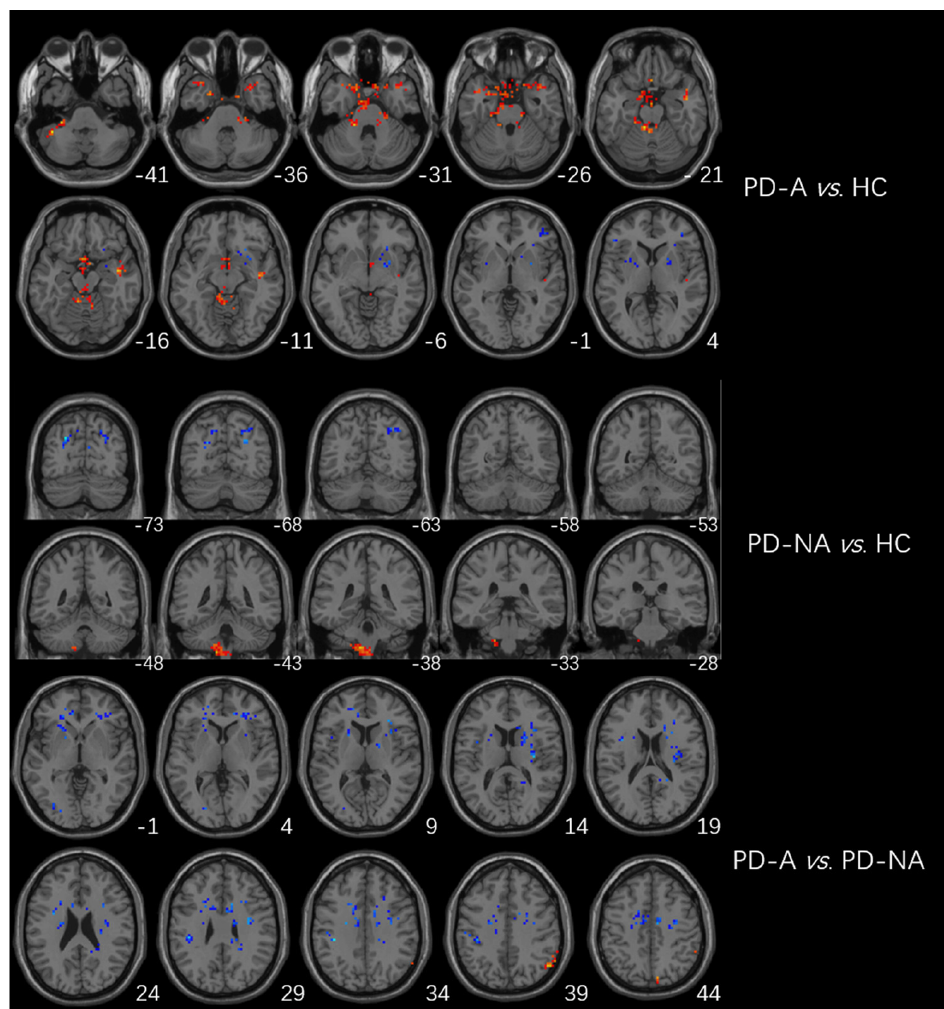
Figure 2. Brain regions showing differences in fALFF between groups. The red region represents the brain region with significantly increased fALFF (PD ‐ A > HC, PD ‐ A > PD ‐ NA, and PD ‐ NA > HC), and the blue region represents the brain region with significantly decreased DC (PD ‐ A < HC, PD ‐ A < PD ‐ NA, and PD ‐ NA < HC).